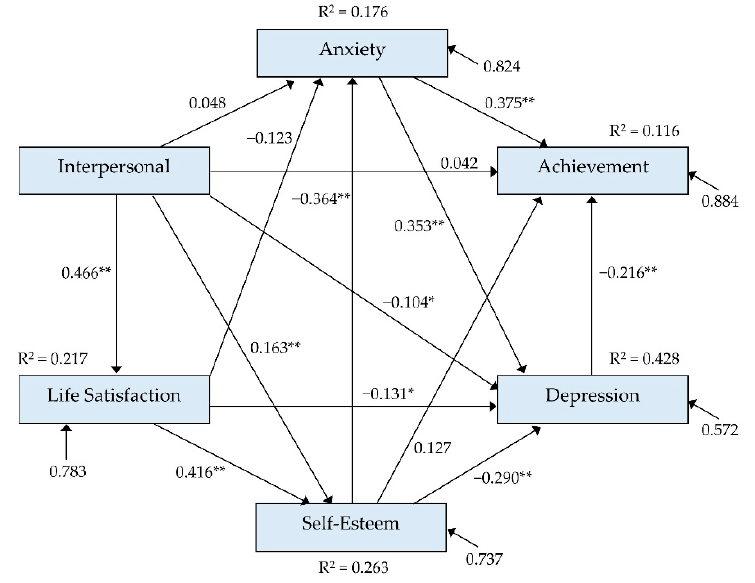
Figure 1. The standardized regression coefficient of factors influencing achievement and depression; * p < 0.05, ** p < 0.01, R 2 : coefficient of determination.